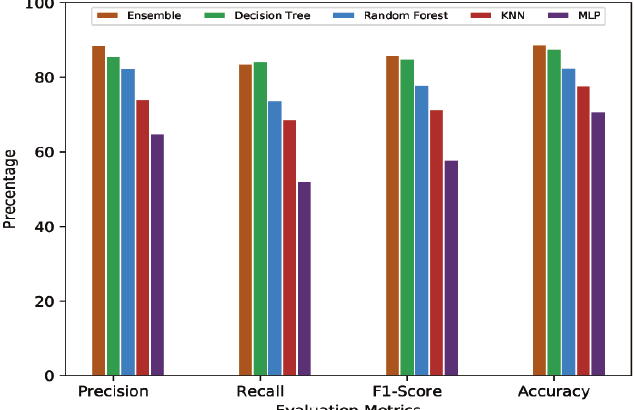
Figure 6. Graphical representation of comparative analysis of ML/DL approaches (prediction validity = 20 min, threshold =